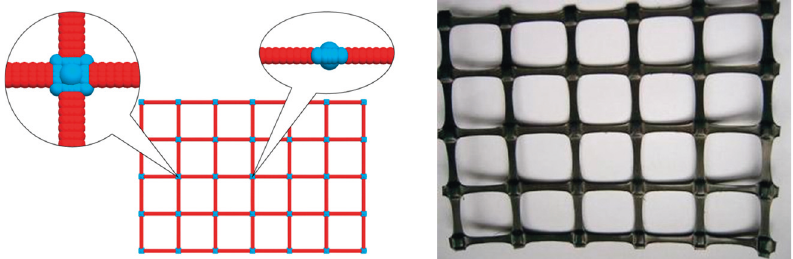
Figure 3: PFC3D geogrid model.